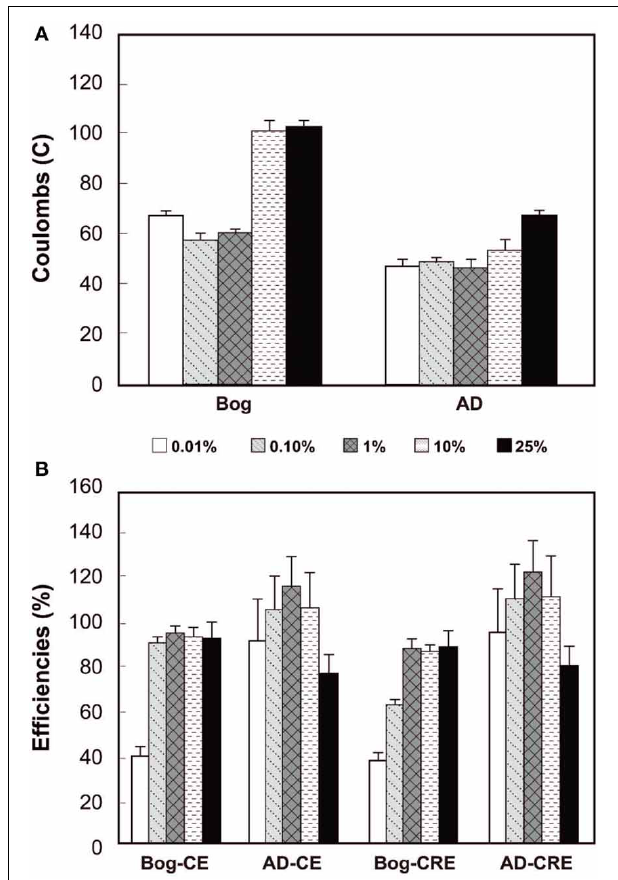
FIGURE 4 | Coulombs transferred (A) and coulombic efficiency (CE) compared to CH 4 recovery efficiency (CRE, both B) as a function of original inoculum size with bog and anaerobic digester sludge (AD) after 3 fed-batch